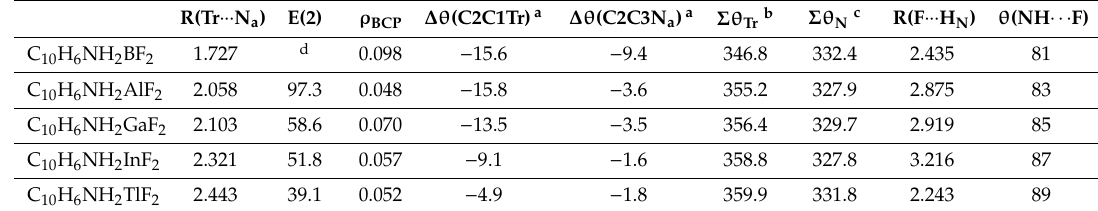
Table 1. Structural parameters (distances in Å, angles in degrees), and the NBO value of E(2) for transfer from N to Tr (kcal / mol), and density at Tr ··· N AIM bond critical point (au), of C 10 H 6 NH 2 TrF 2 calculated at the MP2 / aug-cc-pVDZ level of